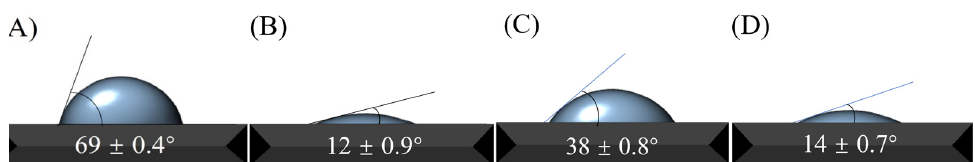
Figure 3. Water contact angle photographs of MWCNTs ( A ), PAA-MWCNTs ( B ), SCS ( C ), and PAA-MWCNTs-Ag-SCS ( D ).